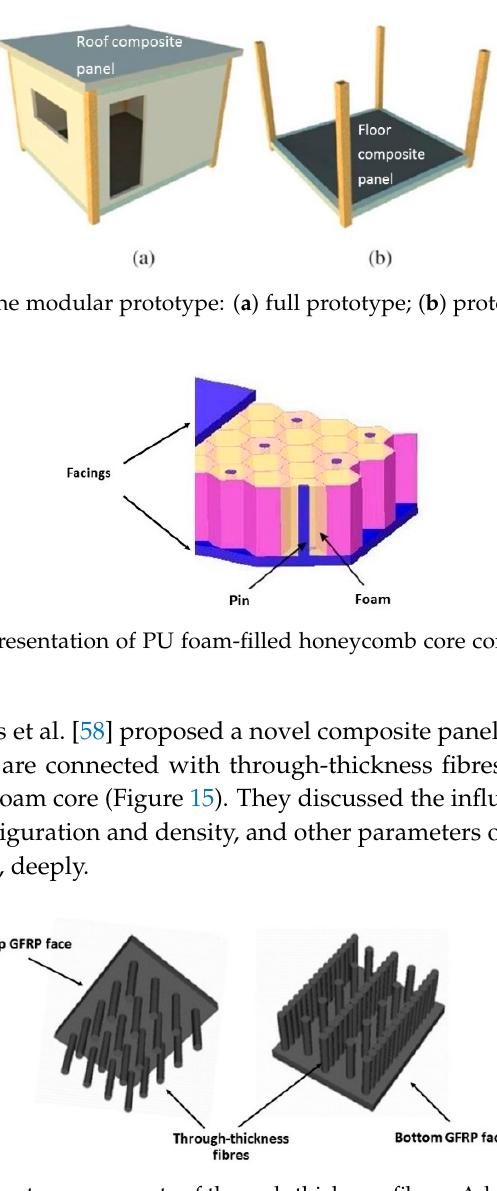
Figure 15. Different arrangements of through ‐ thickness fibres. Adapted from [58] .